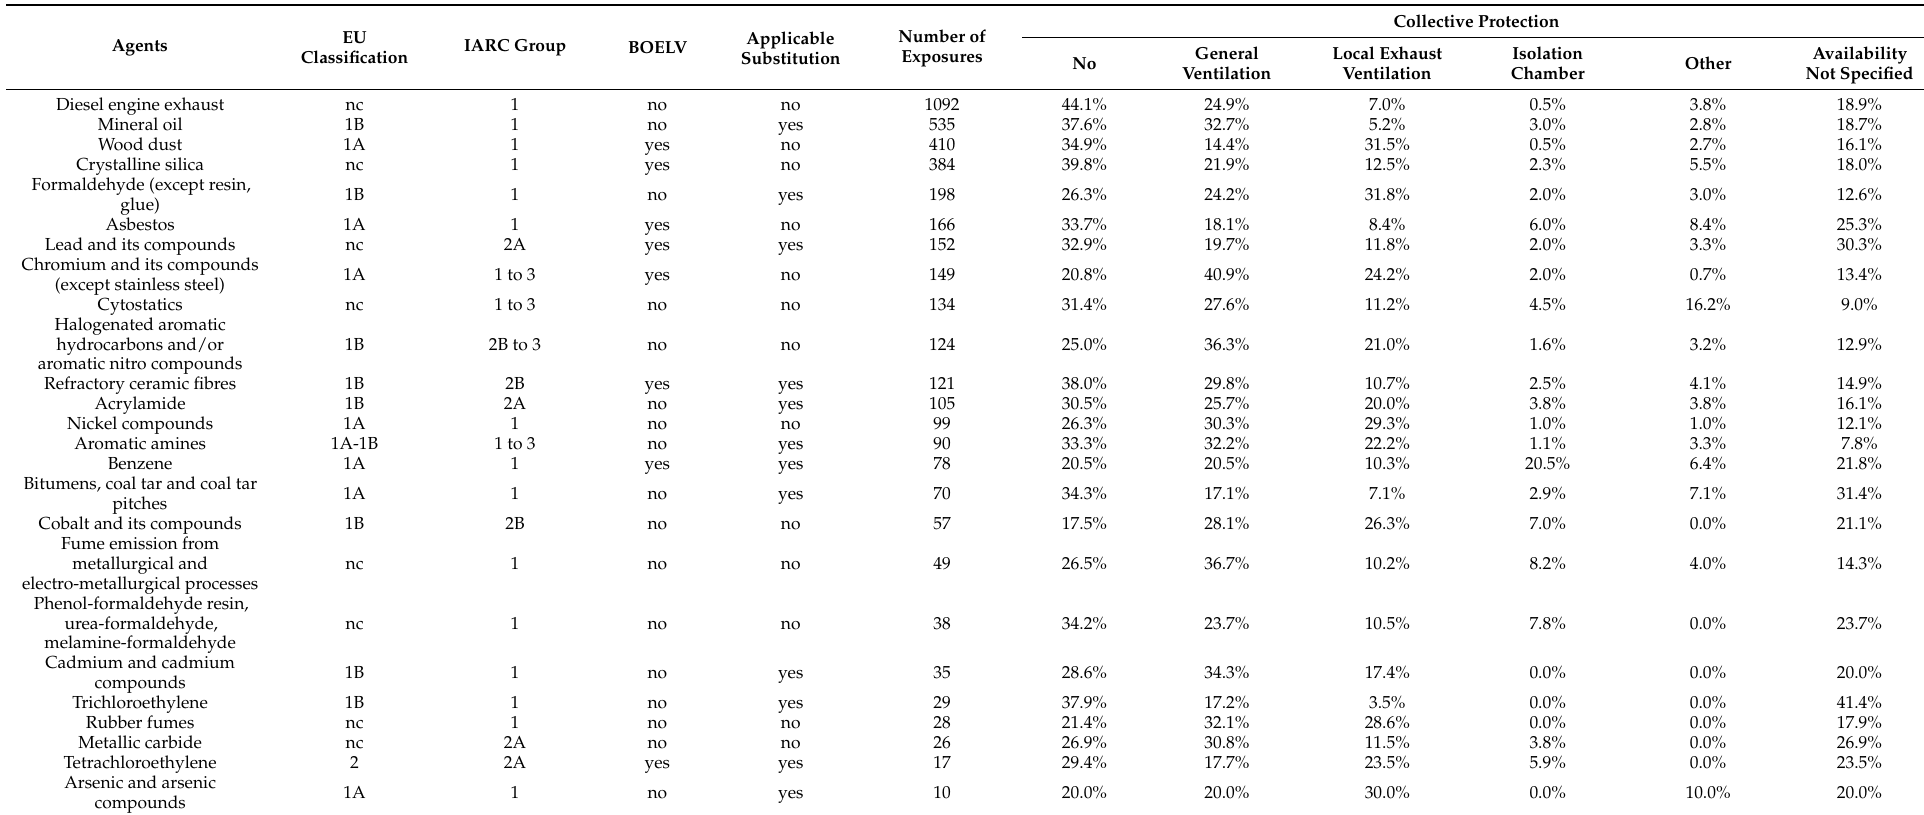
Table 1. Availability of collective protection against the 4196 exposures to 25 selected carcinogenic agents in the 2017 national cross-sectional survey of occupational hazards